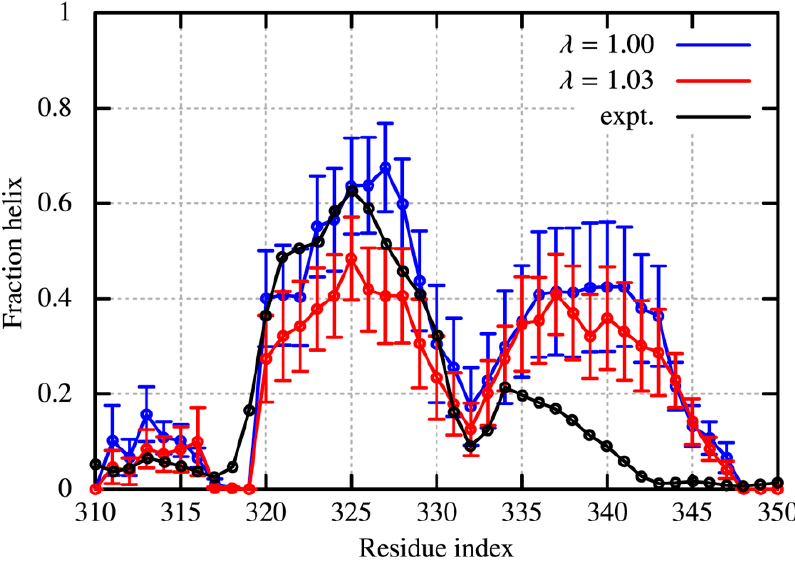
Figure 4. Fraction of helix in the C-terminal domain of TDP-43 for the conditions of 𝜆 = 1.00 (blue) and of 𝜆 = 1.03 (red), and for the NMR measurement (black). The helicity is evaluated through the DSSP algorithm.